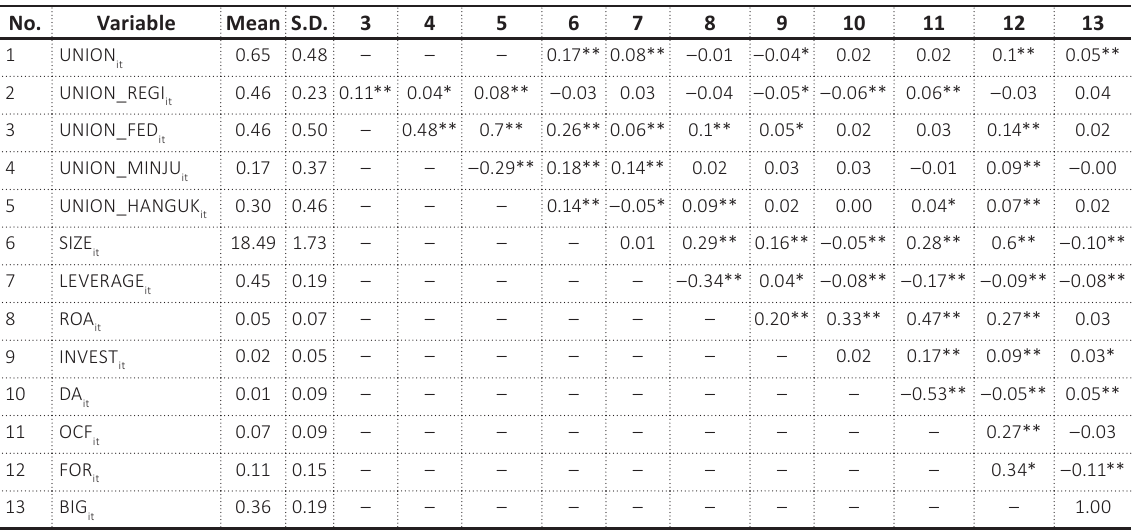
Table 1. Descriptive statistics and